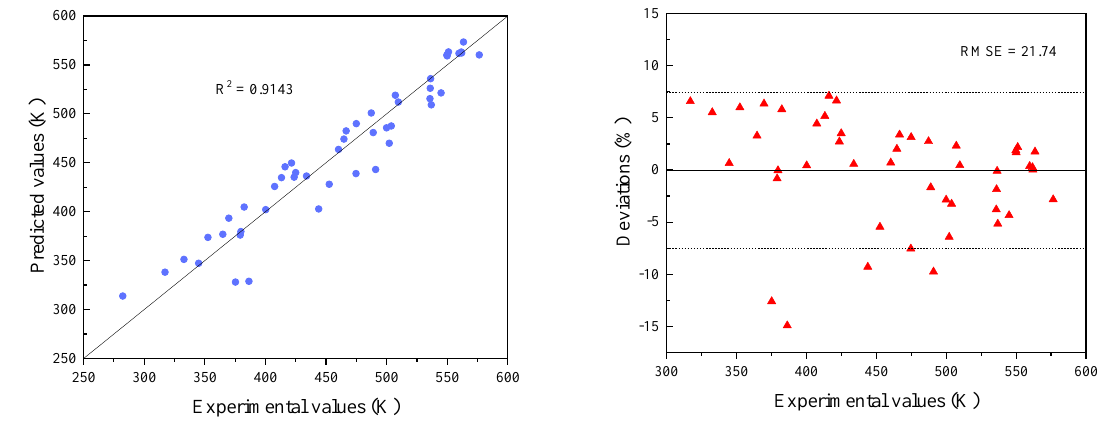
Figure 5. Predictive performance of the MLP + modified Pubchem model.